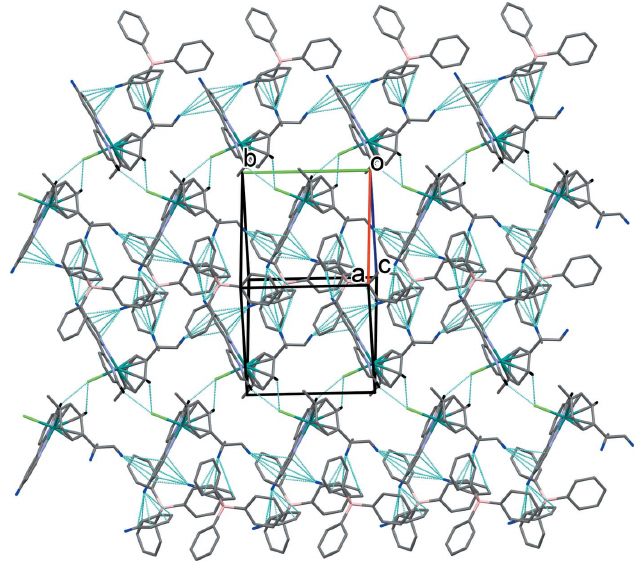
Figure 2 Aview normal to plane (101) of the crystal packing of complex 1 . The C— H (cid:2)(cid:2)(cid:2) Cl hydrogen bonds and C—H (cid:2)(cid:2)(cid:2) (cid:2) interactions (see Table 2) are shown as dashed lines. For clarity, only the hydrogen atoms involved in these interactions have been included.